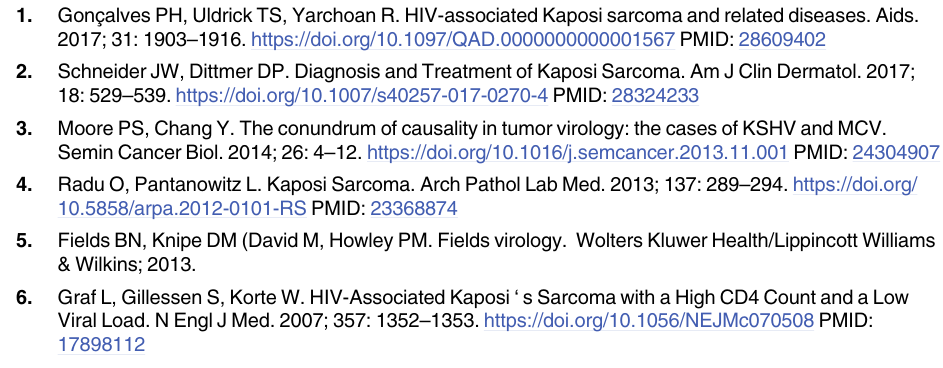
S8 Table. Correlations of observed KSHV mutations. (XLSX) S9 Table. KSHV genetic polymorphisms on survival rates. (XLSX)